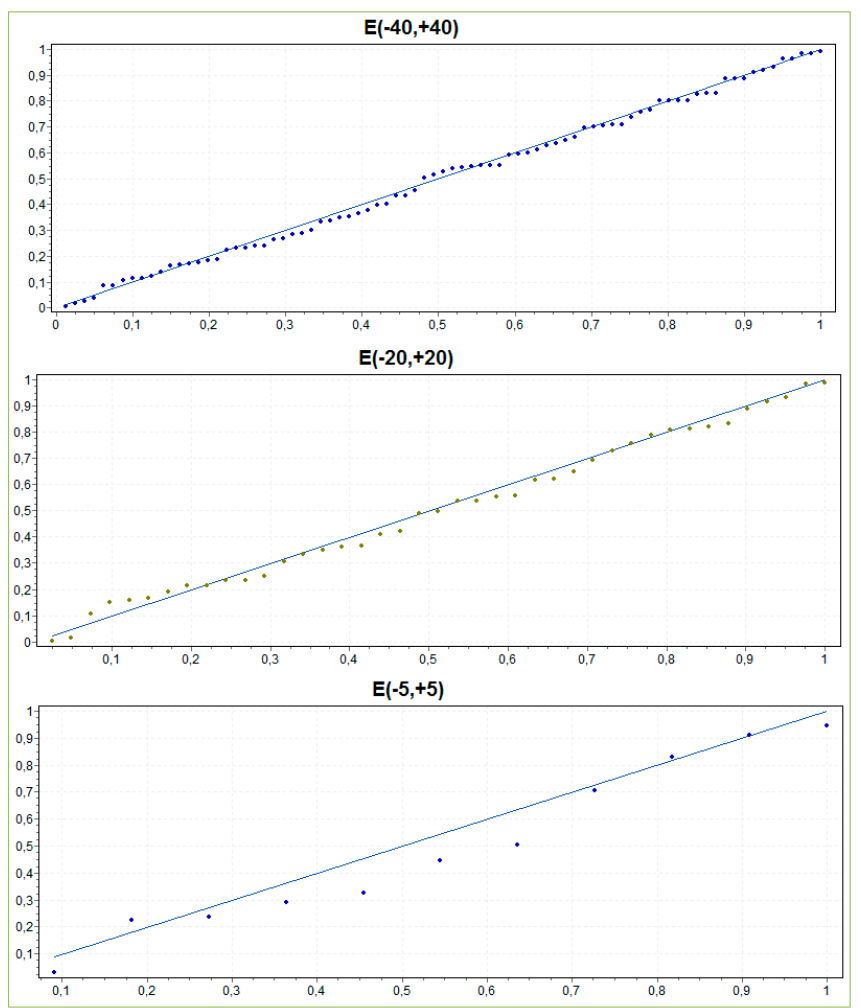
Figure 1. P-P plots for E ( − 5,+5), E ( − 20,+20), and E ( − 40,+40) .